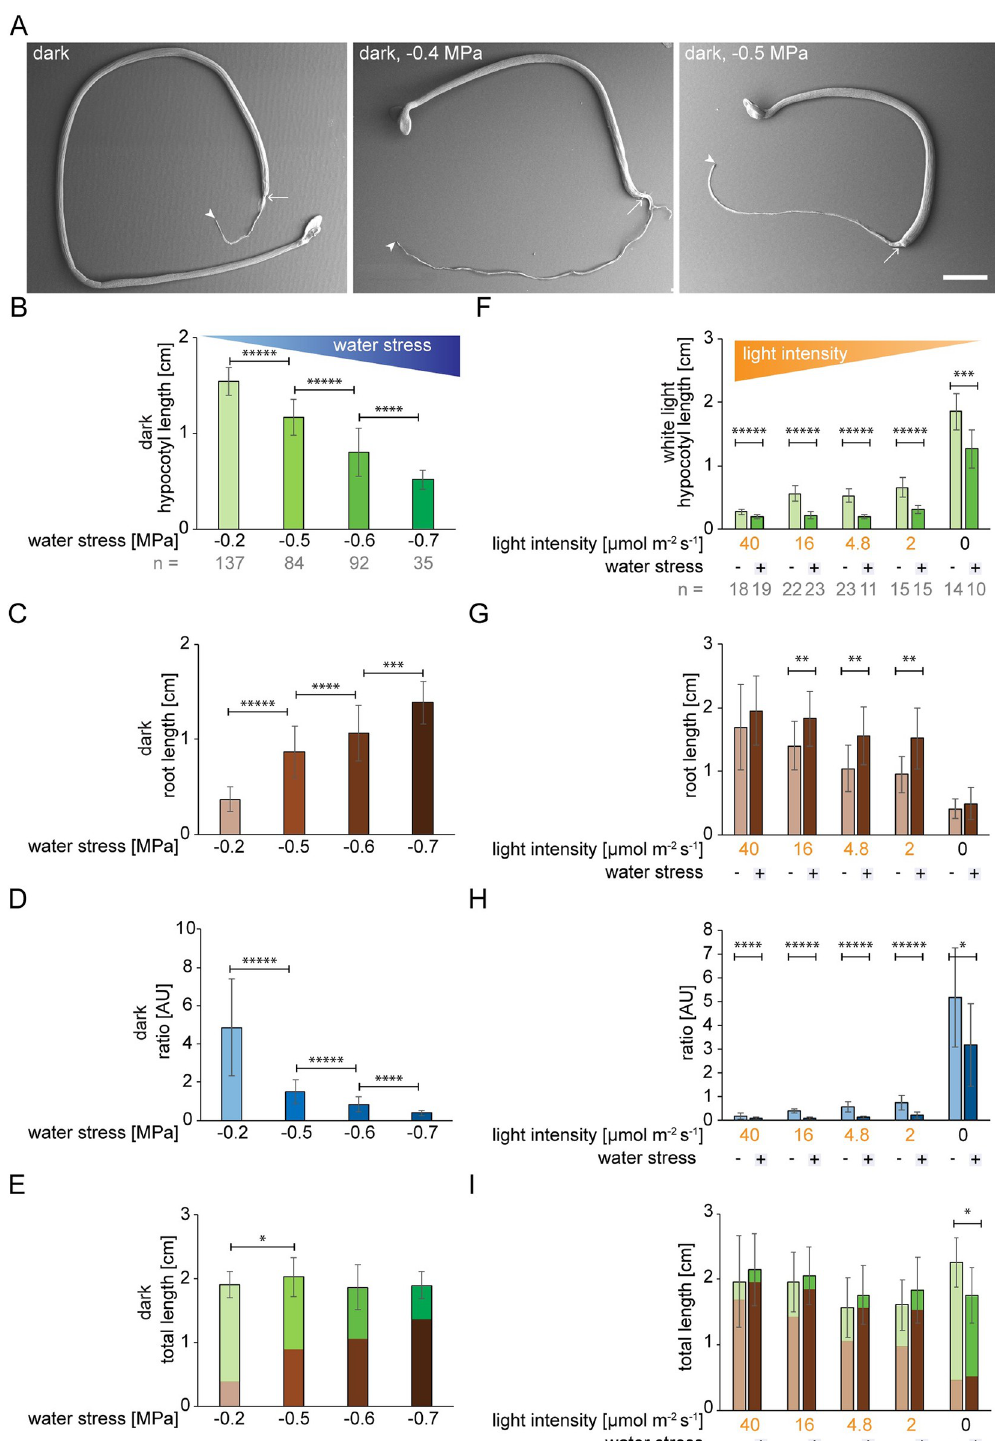
Fig 1. Hypocotyl versus root growth in response to light and water availability. Wild type (Col-0). (A-E) germination in the dark on a gradient of water stress ranging from 0 to -0.7 MPa. Recordings were taken 10 days after germination. (A) scanning electron micrographs; arrows point to the hypocotyl/root junction and arrowheads to the end of the root. (B-E) panels are from the same experiment. Water stress applied in the dark increases root length (C) at the expense of hypocotyl length (B), giving rise to a decrease in the hypocotyl/root ratio (D). Note that the total seedling length does not vary at